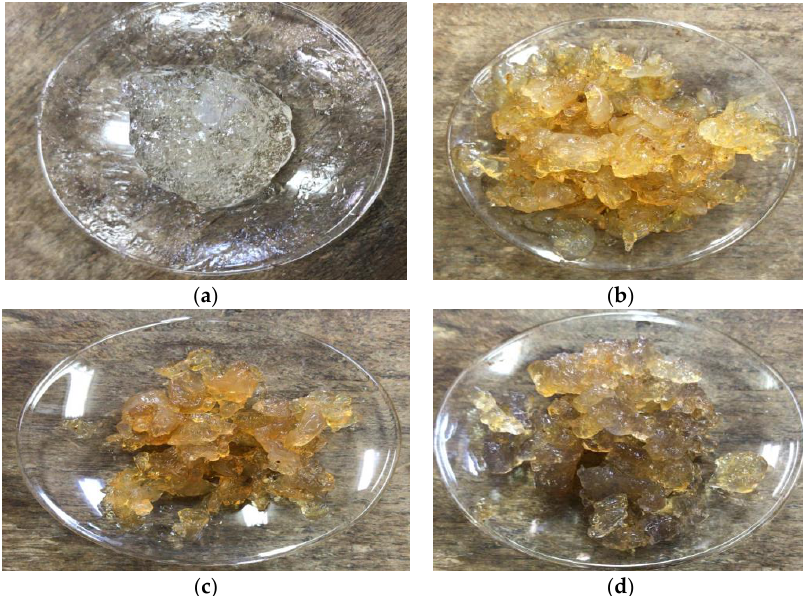
Figure 6. Digital photographs of prepared hydrogels. ( a ) Chitosan hydrogel; ( b ) 2% chitosan/0.5% Ag-